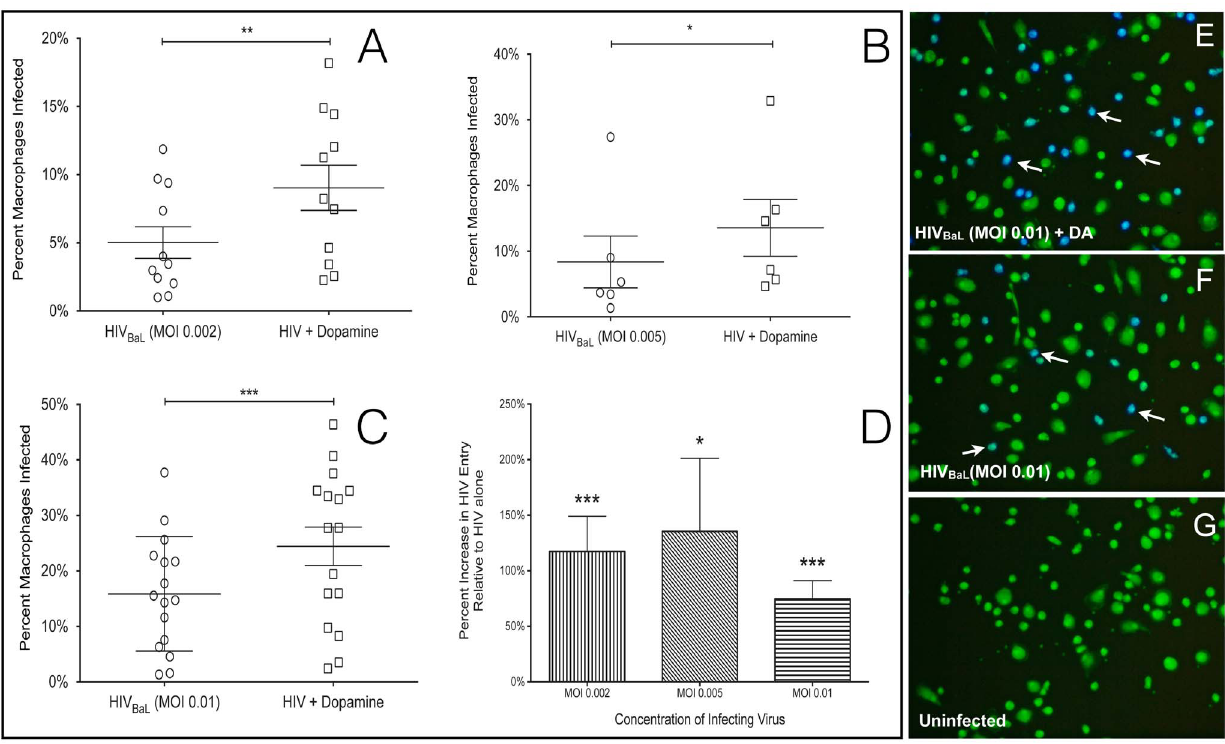
Figure 1. Dopamine increases HIV entry into primary human macrophages. Primary human monocyte derived macrophages were infected with 3 concentrations of b -lac HIV (MOI of 0.002, 0.005, 0.01) in the presence of either 2 6 10 8 M, 2 6 10 7 M, 2 6 10 6 M or 2 6 10 5 M dopamine, and control cells were infected with HIV alone. In panels A-C each circle or square represents infection of macrophages from a single donor. Dopamine significantly increased viral entry in macrophages infected with all concentrations of HIV (A, MOI 0.002, n=11, ** p=0.0002), 0.005 (B, n=6, * p=0.0313) or 0.01 (C, MOI 0.01, n=16, *** p=0.001) after 4 hr incubation. Panel D shows the percent increase in entry mediated by dopamine in infections with each concentration of HIV relative to control (MOI 0.002 vertical lines, MOI 0.005 diagonal lines, MOI 0.01, horizontal lines). Panels E - G show representative images of cultures infected with 0.01 MOI b -lac HIV in the presence of (E) dopamine, (F) HIV alone, (G) and uninfected macrophages. White arrows indicate infected